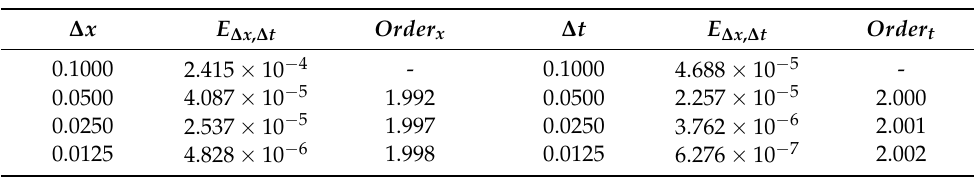
Table 1. Convergence error. For space convergence, we fix ∆ t = 1/1000. For temporal convergence we fix ∆ x = 1/1000.